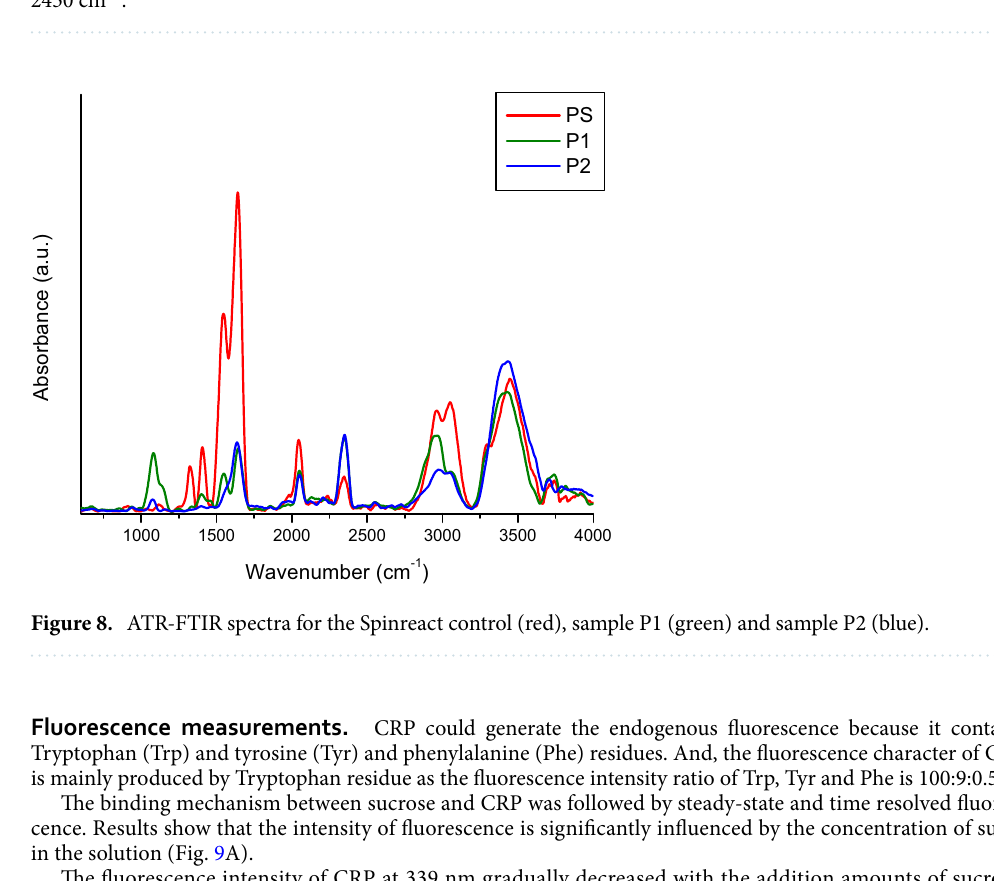
Figure 7. ATR-FTIR spectra of CRP standard (red), sample P1 (green), Sample P2 (blue), range from 1450 to 2450 cm −1 .